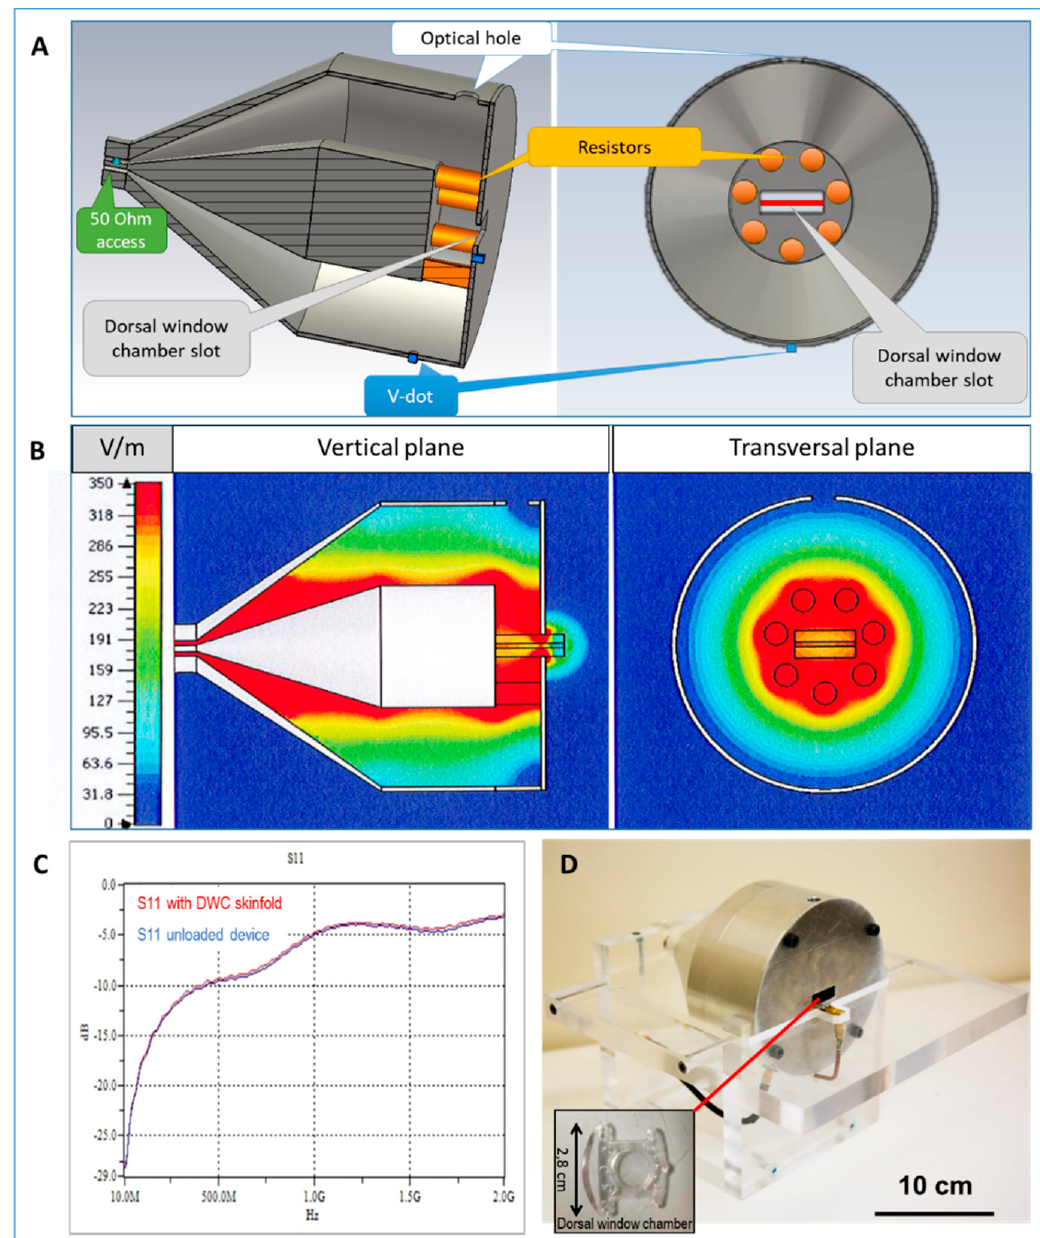
Figure 2. Design and properties of the coaxial dorsal window chamber (DWC) applicator. ( A ) Schematic representation of the longitudinal and the cross section of the applicator. ( B ) The E − field homogeneity as evaluated by 3D electromagnetic simulation using 3D CST software calculated over the vertical (left) and the transversal plane (central section of the test volume) of the applicator loaded with the murine skinfold. ( C ) Measured S11 parameter of the applicator (loaded and unloaded with the DWC). ( D ) Photograph of the applicator and the DWC (inset figure), which is inserted into the slot (red line) and allows vasculature monitoring under the microscope (via the optical hole at the top of the device). The inset shows an empty DWC. The figure is adapted from reference [9].